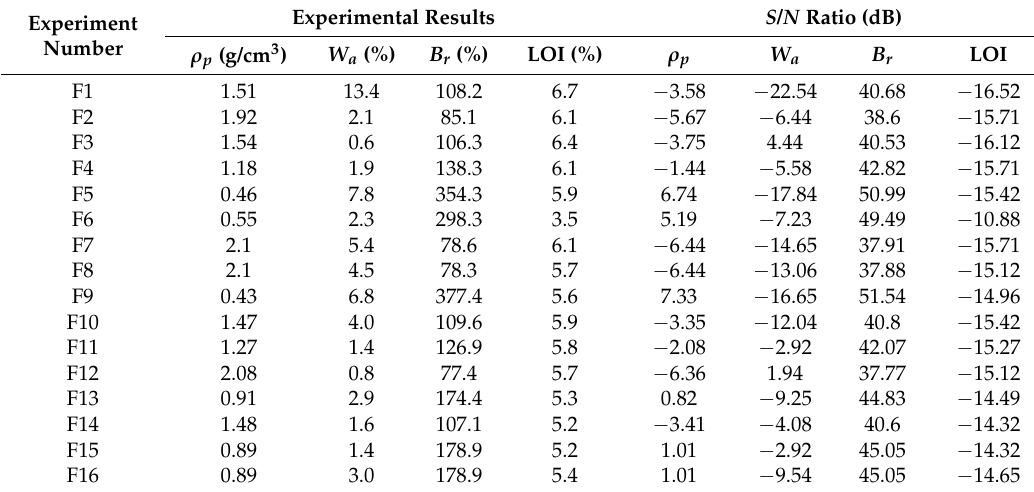
Table 5. Experimental results and S/N ratio.